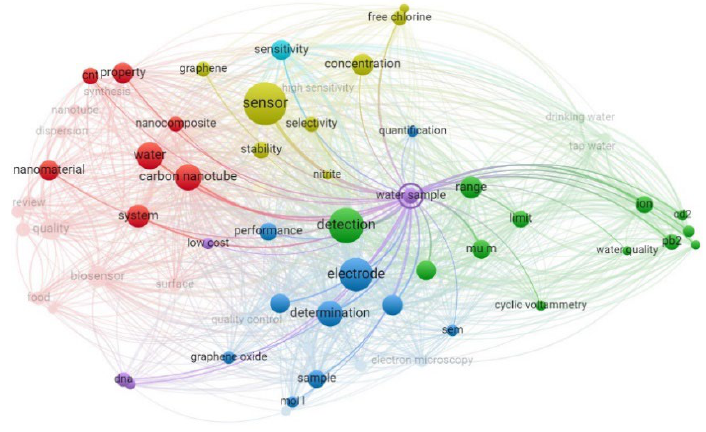
Figure 9. Cluster 5 Network—“water sample” main keyword.